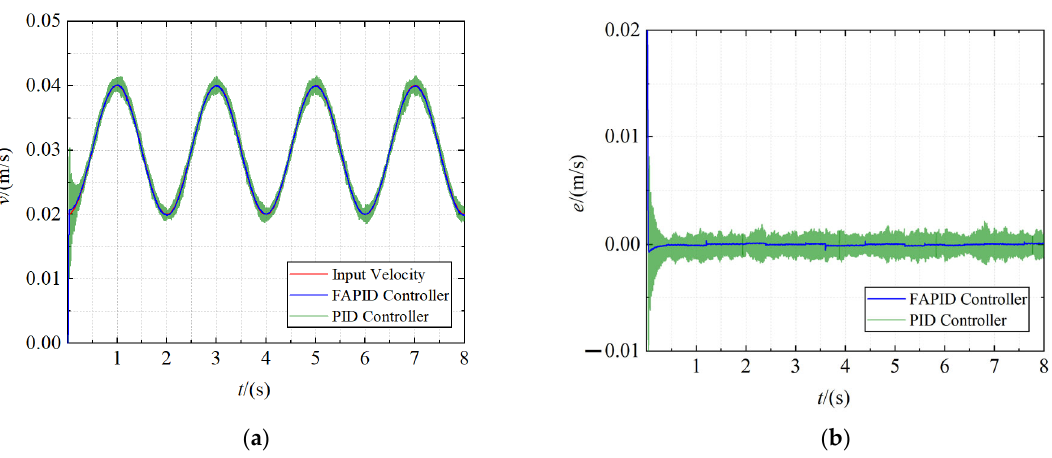
Figure 14. The towing curve. ( a ) The velocity tracking curve; ( b ) the error curve.